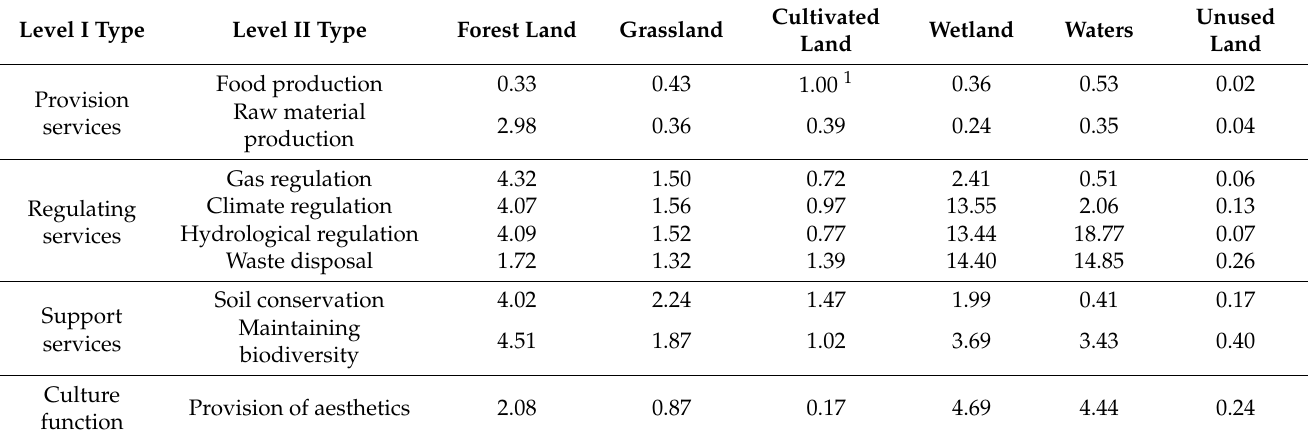
Table 2. Value-equivalent of ecosystem services per unit area in China